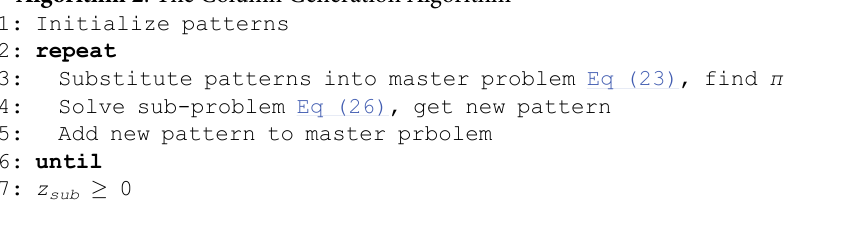
Algorithm 2 : The Column Generation